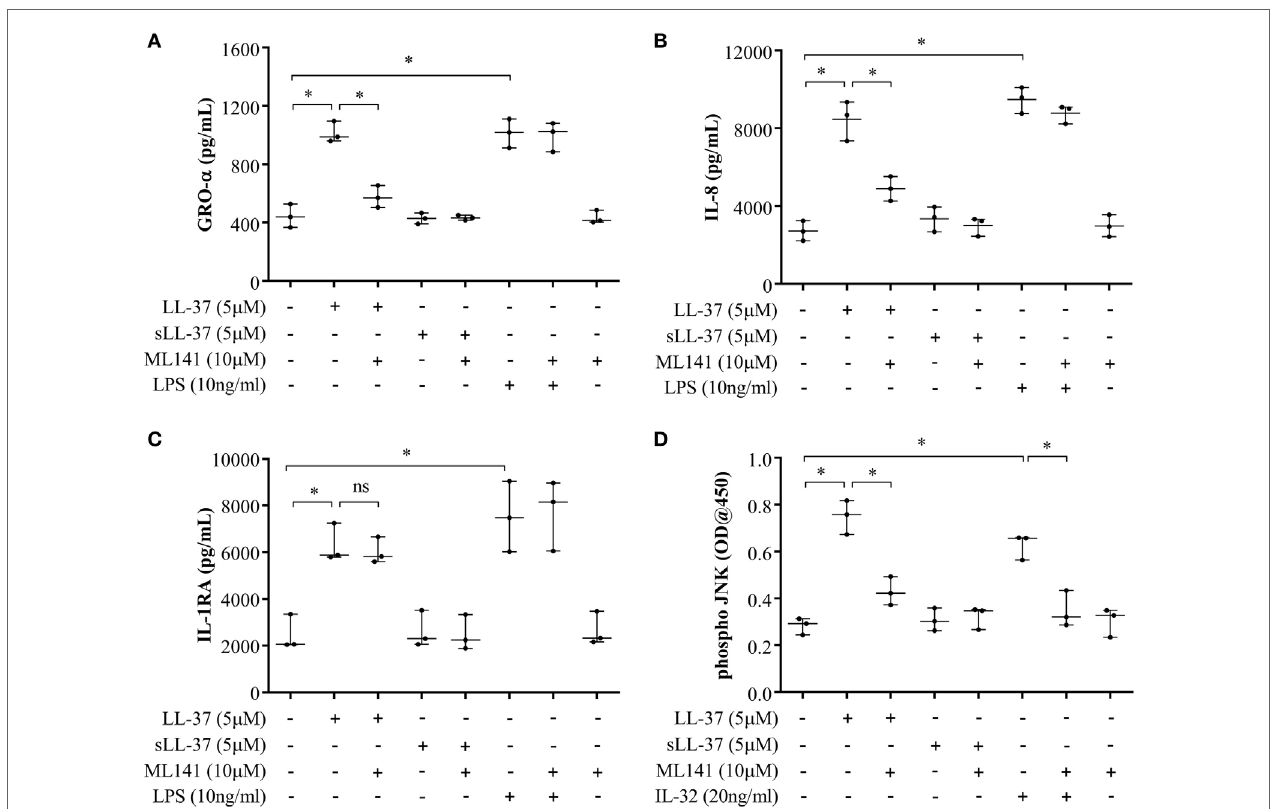
FigUre 5 | Cdc42/Rac1 Rho GTPase controls LL-37-induced chemokine secretion and JNK mitogen-activated protein kinase (MAPK) phosphorylation in human monocyte-derived macrophages (MDM). Human MDMs were pre-incubated with Cdc42/Rac1 inhibitor ML141 (10 µM) for 1 h prior to stimulation with either